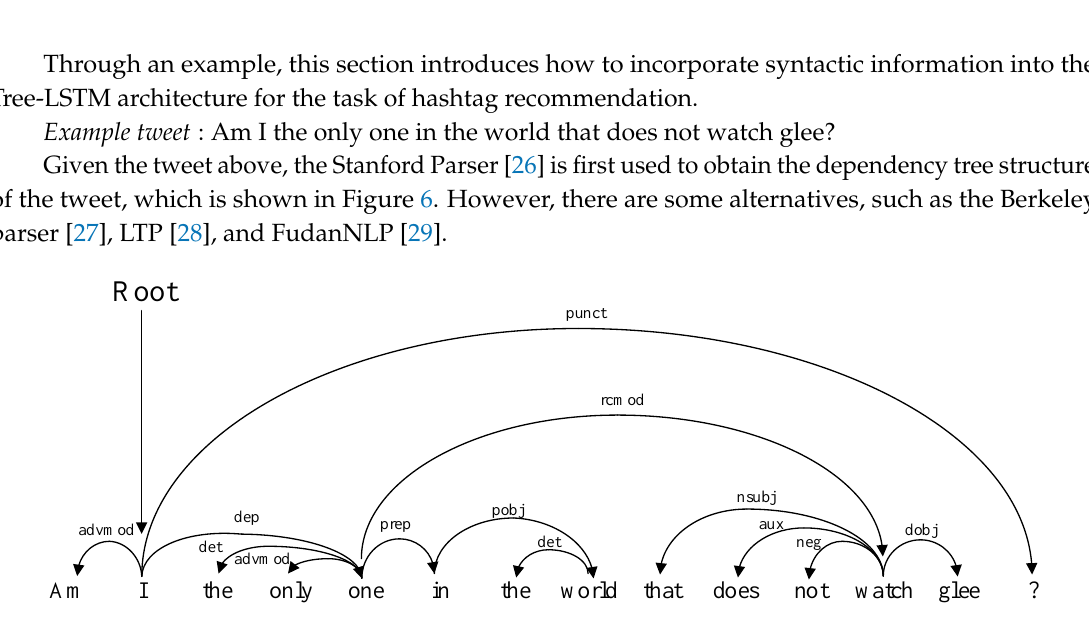
Figure 6. The dependency relations of the example tweet.